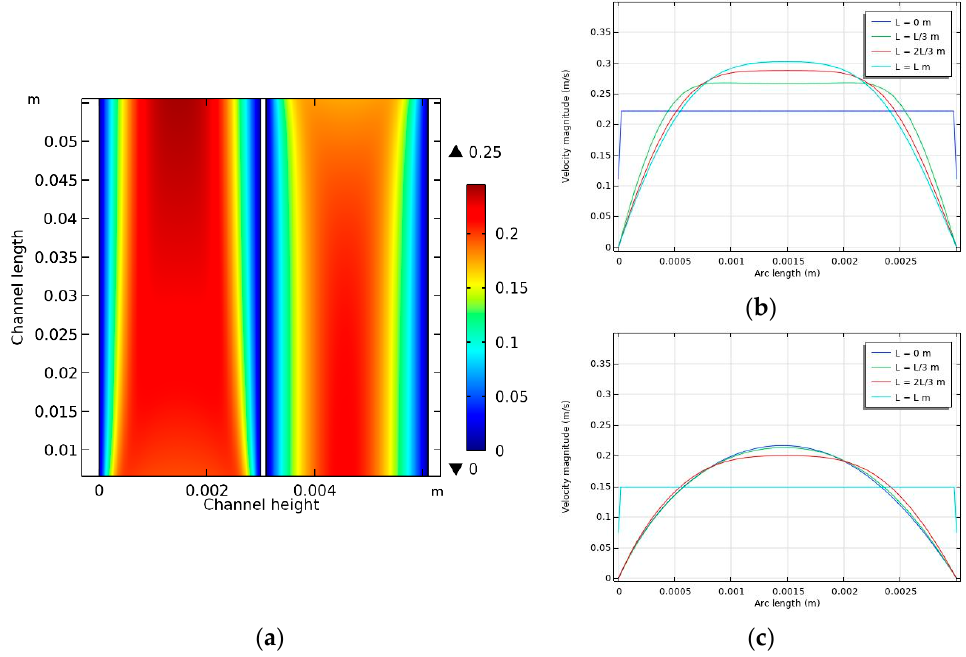
Figure 4. Flow velocity distribution inside the module: ( a ) velocity contour in the feed and permeate sides, ( b ) feed side, and ( c ) permeate side. Conditions: feed temperature = 60 °C, feed flow rate = 0.6 L/min, and permeate flow rate = 0.4 L/min.